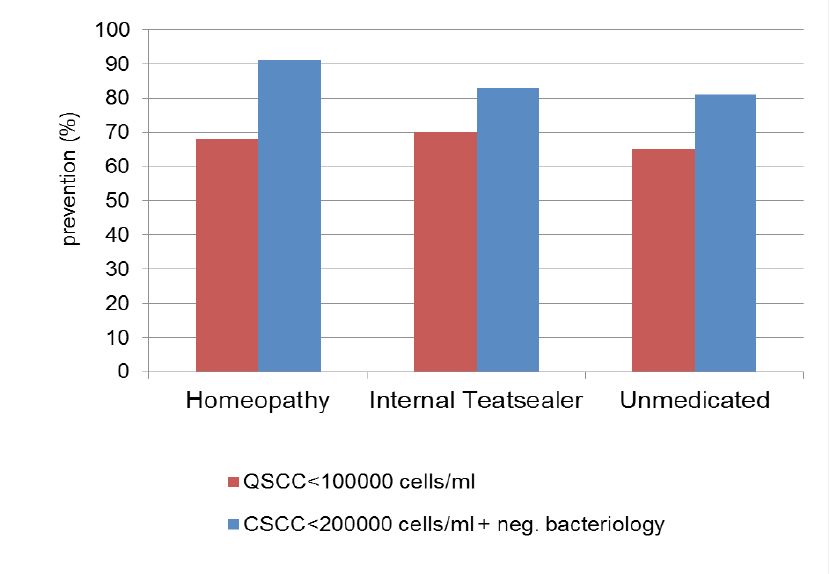
Figure 3: Prevention of mastitis in three trial groups compared between quarter somatic cell count (QSCC) and cow somatic cell count (CSCC) (Data from: Klocke et al.